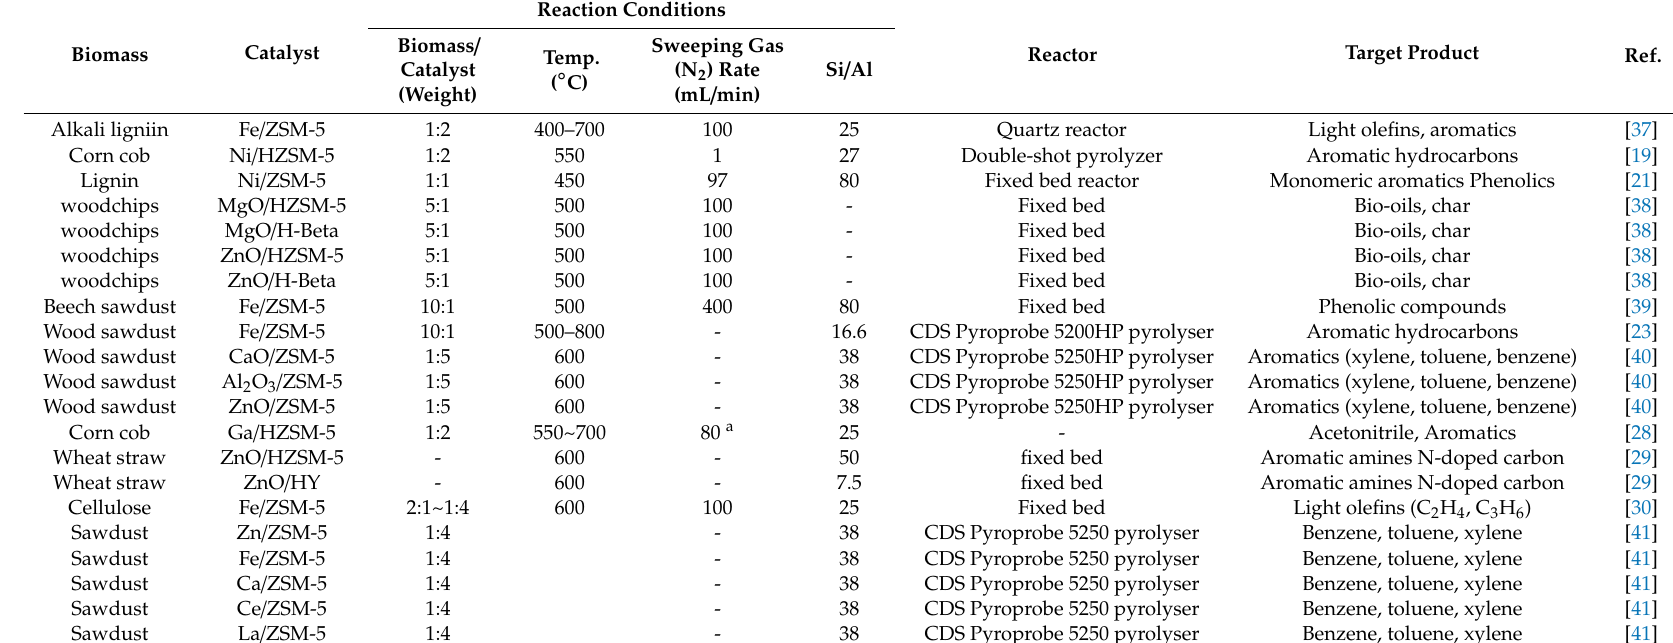
Table 2. Application of metal modified zeolite catalysts in